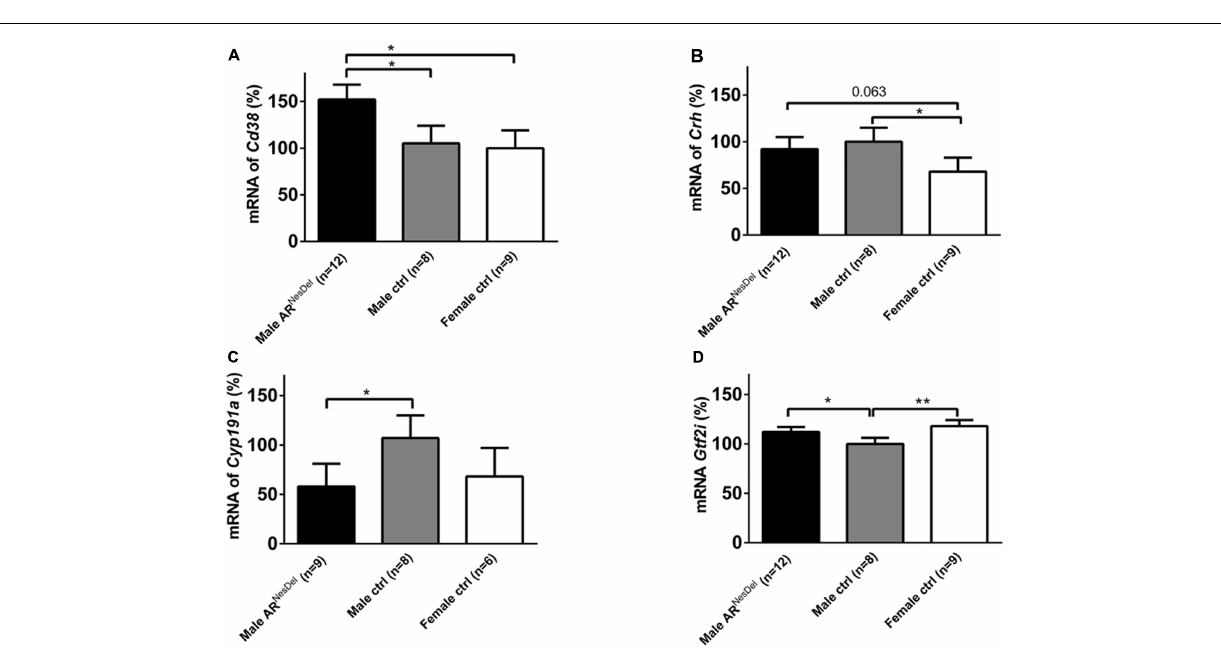
FIGURE 8 | mRNA expression levels of (A) Cd38 , (B) Crh , (C) Cyp19a1 , and (D) Gtf2i in the amygdala of male AR NesDel , as well as in male (wildtype, AR flox , NesCre + / − ) and female (wildtype, ARflox + / − ) controls. The results are presented as percent ( ± SEM) in relation to the male control group. ∗ p < 0.05, ∗∗ p <